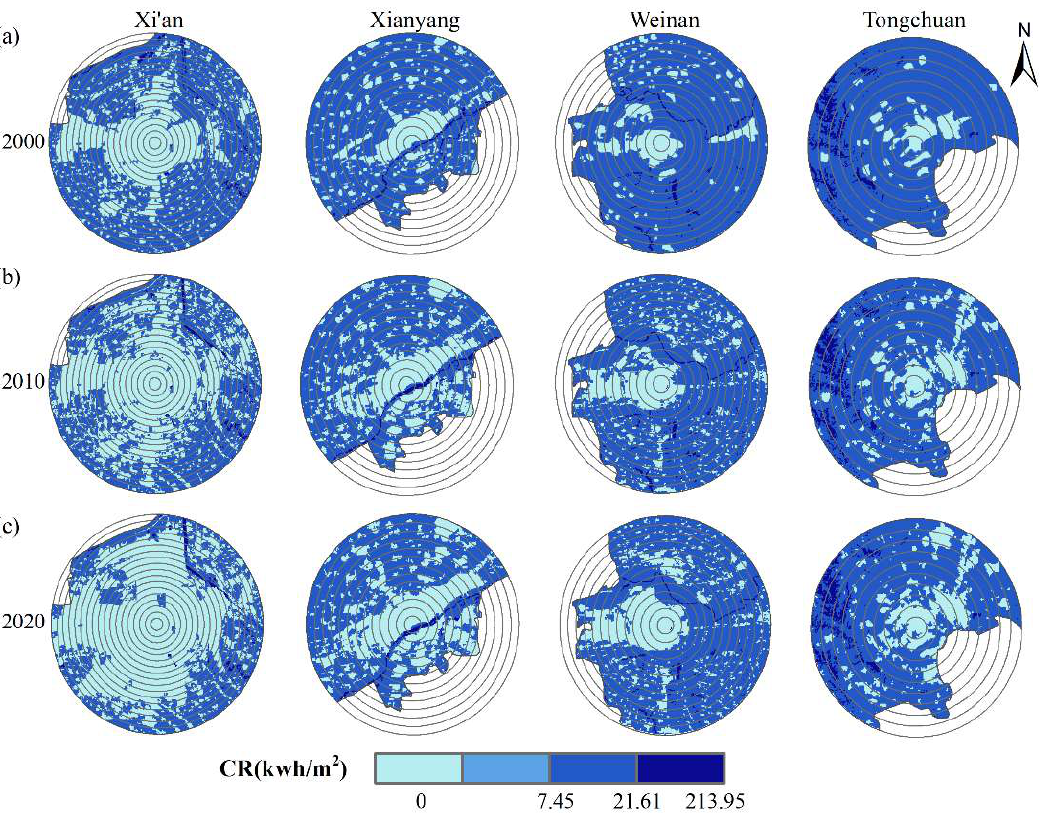
Figure 4. Spatio-temporal dynamic maps of climate regulation (CR) in ( a ) 2000, ( b ) 2010, and ( c ) 2020 in the XMA (unit: kwh/m 2 ).